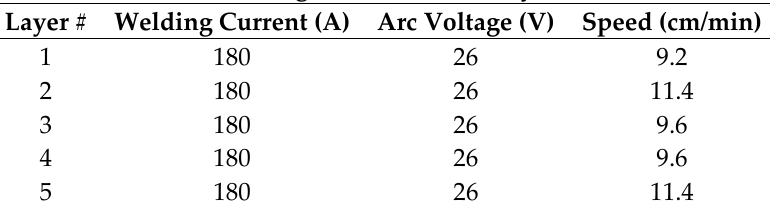
Figure 4. Welding conditions of FCAW.